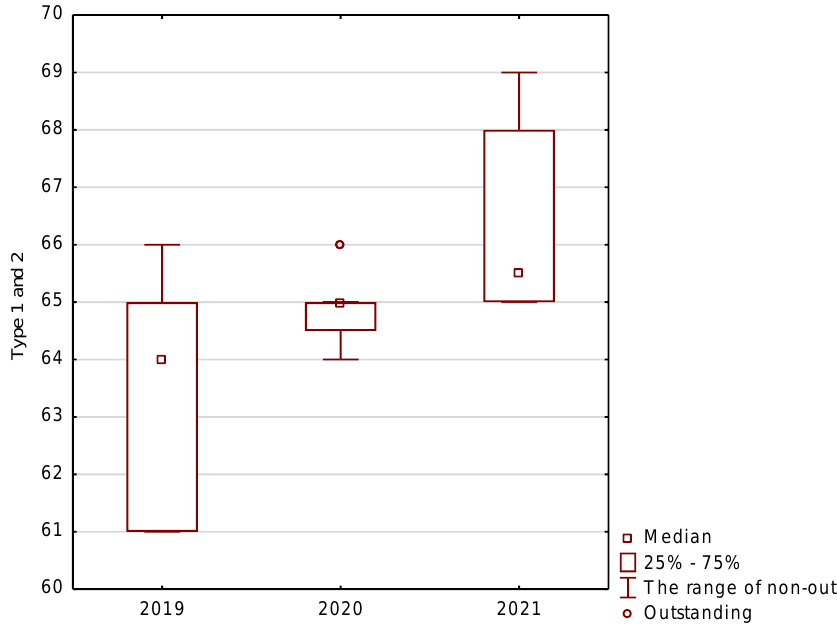
Figure 12. Box plots for the analysis of vehicle charging method — type 1 and 2.